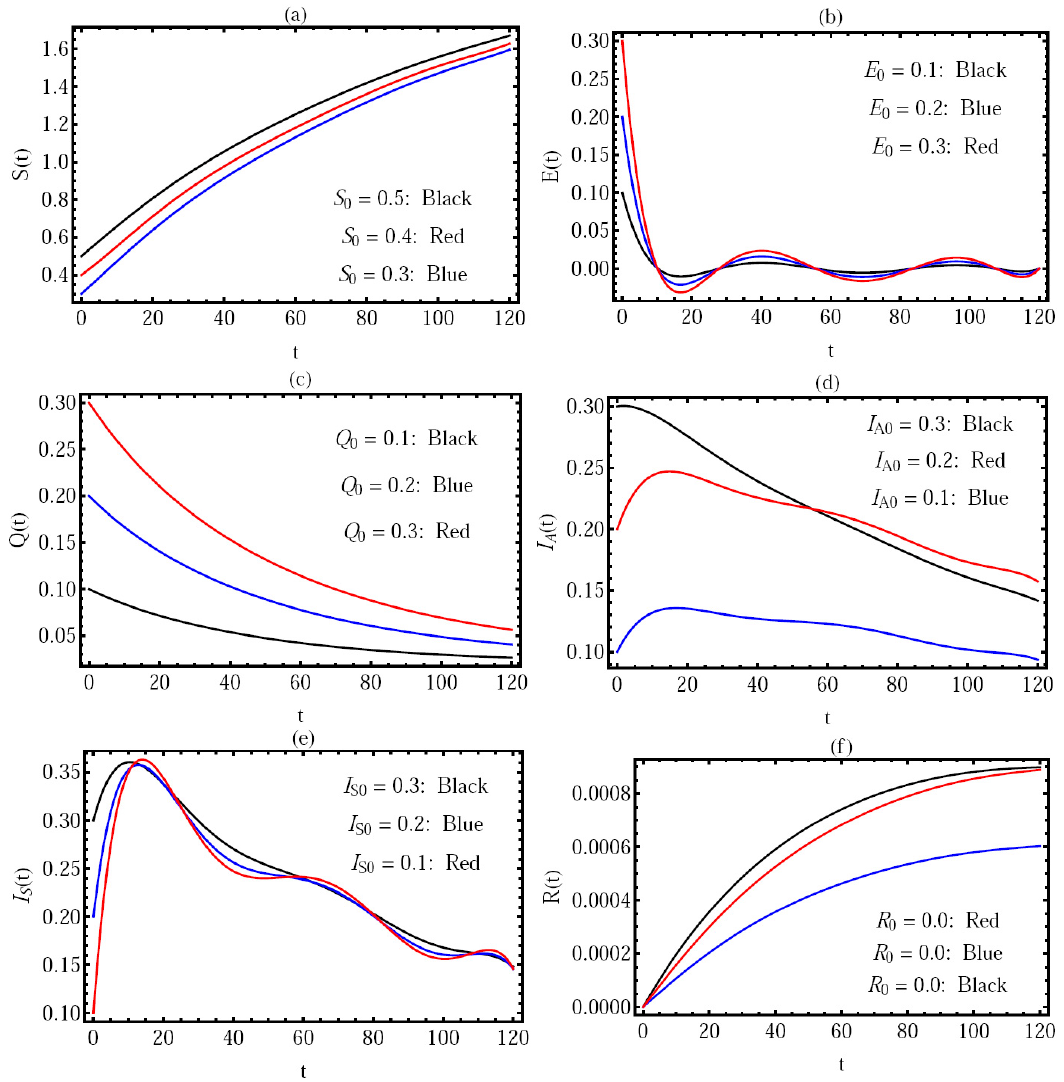
Figure 5. The solution via different values of initial values ( a – f